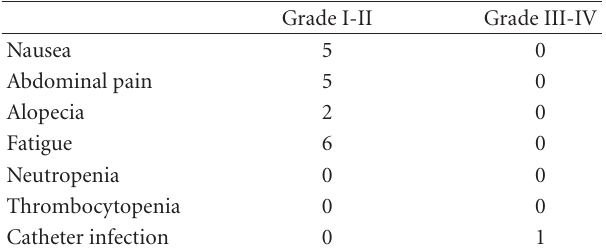
Table 2: Toxicities observed in ten patients treated with adjuvant intraperitoneal pemetrexed combined with intravenous cisplatin following cytoreductive surgery and hyperthermic intraperitoneal chemotherapy for di ff use malignant peritoneal mesothelioma.